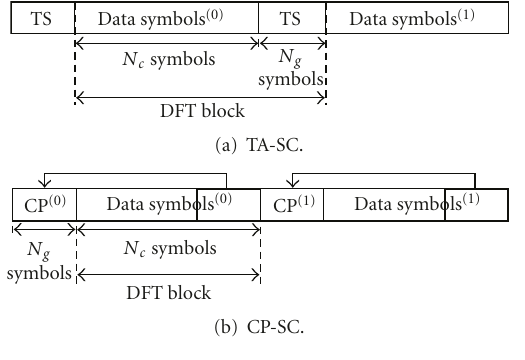
Figure 1: Block structure.